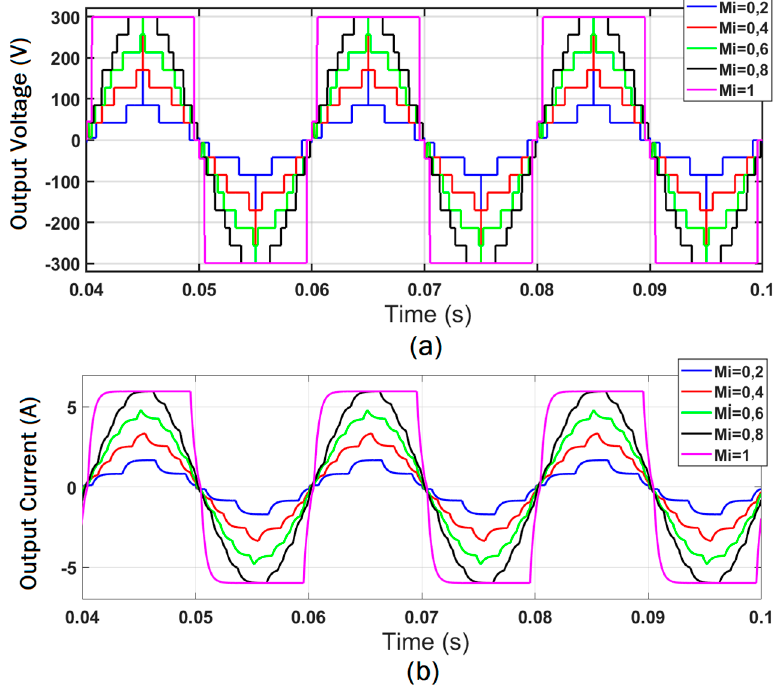
Figure 10. The effect of modulation index variations on the output currents and voltages of 15-level MLI employing the SPBO method.